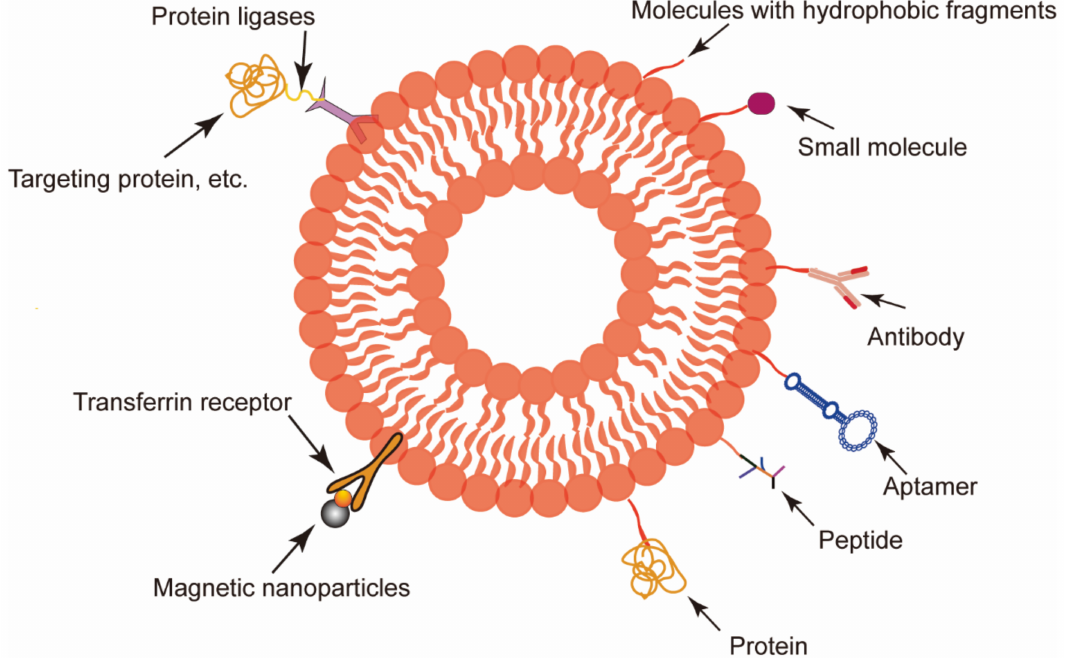
Figure 3. Surface modification method of red blood cell-derived extracellular vesicles (RBCEVs). RBCEVs were modified to obtain targeting ability by utilizing the proteins on the surface of RBCEVs and taking advantage of the properties of the cell